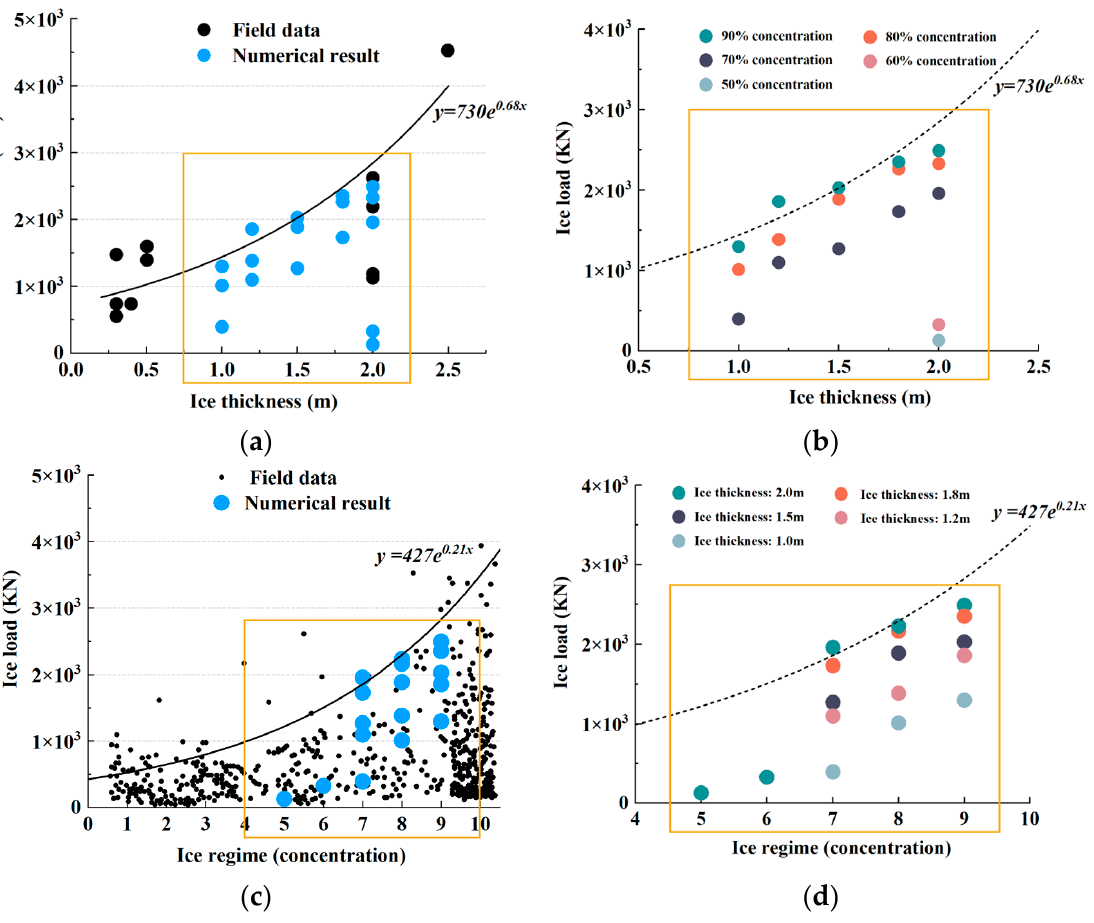
Figure 8. Comparison between the numerical simulation results and field data. ( a ) Ice thickness; ( b ) Ice thickness (Different colors represent different ice concentrations); ( c ) Ice concentration; ( d ) Ice concentration (Different colors represent different ice thicknesses).